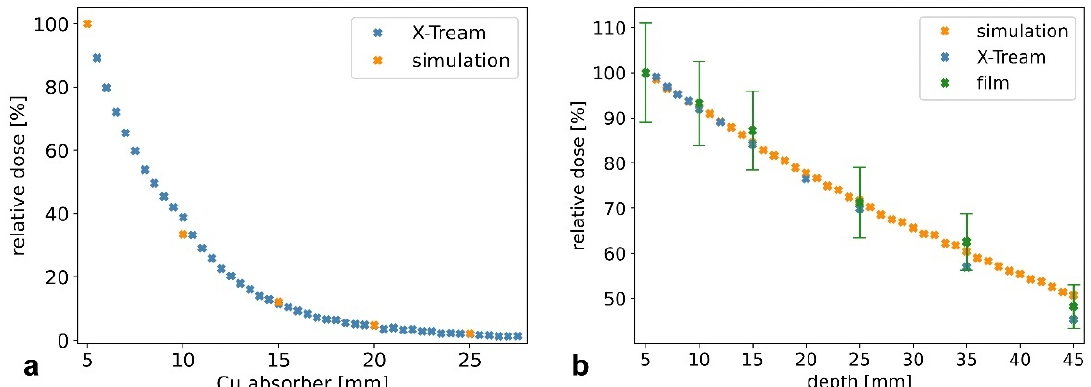
Figure 5. Characterizing the dosimetry properties of the white-beam beamline with different dosimeters and Monte Carlo simulations. Relative dose rate for increasing Cu thickness ( a ). Depth-dose curve in PMMA for a Cu thickness of 10 mm ( b ). The error bars for the measurements with the X-Tream system are as large as the symbols representing the experimental